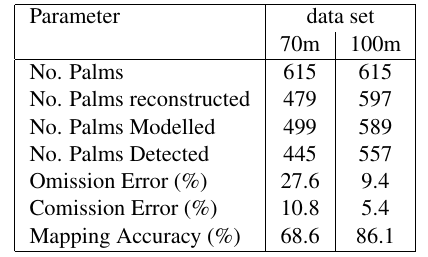
Table 2: Palm Tree Detection results for the two datasets (70m and 100m) based on all reference palms.